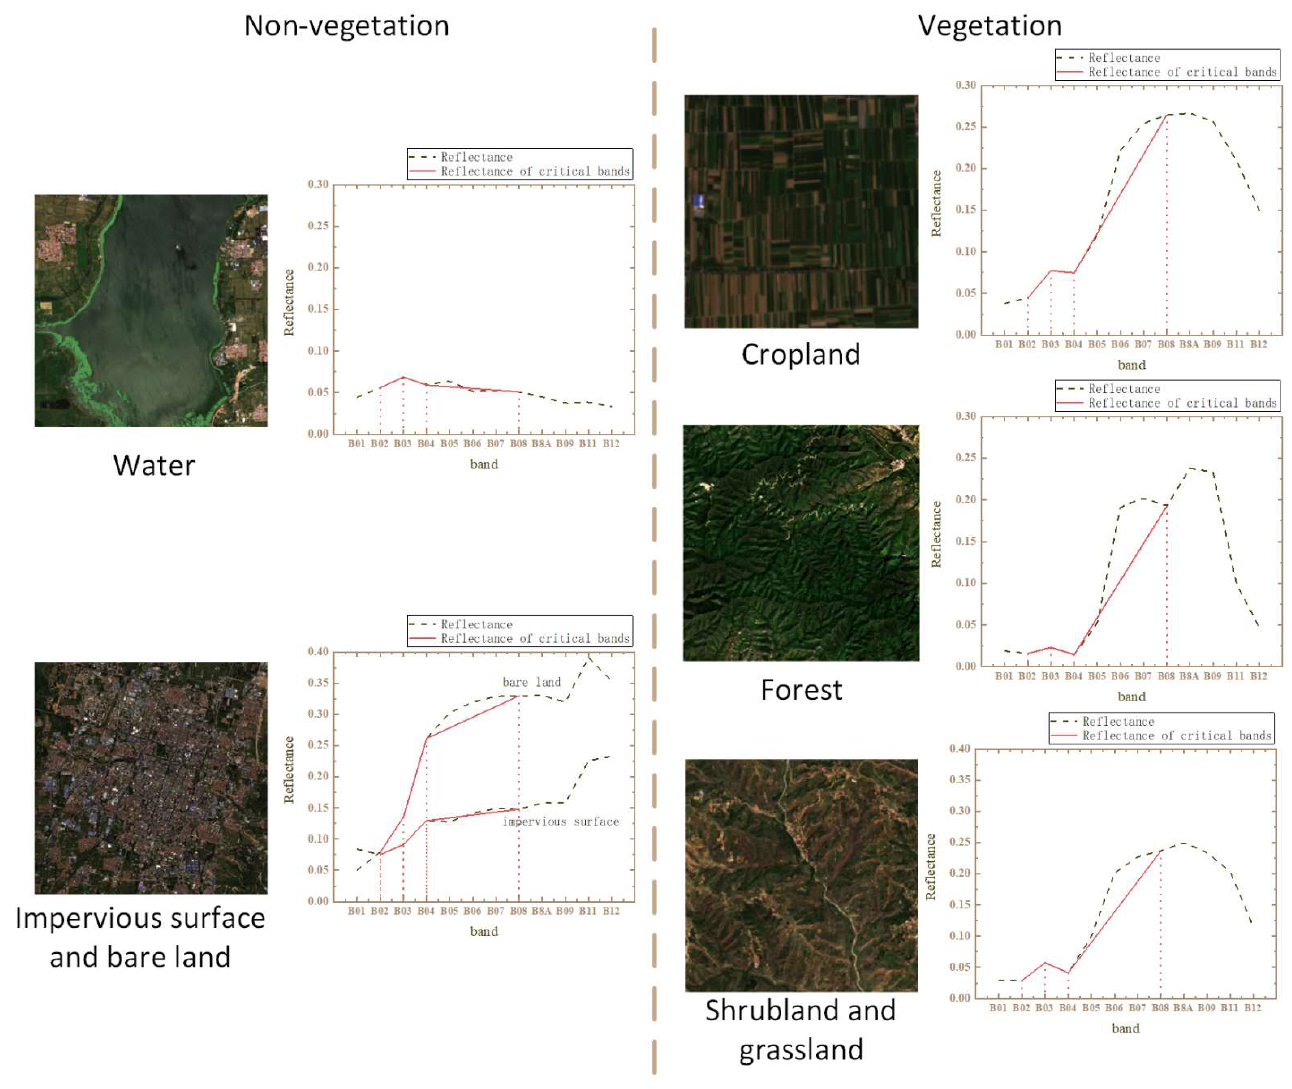
Figure 3. Satellite true-color images of each land use and their corresponding Sentinel-2 spectral curves. The black dotted line indicates the reflectance of all bands of sentinel-2 images. The solid red line represents the reflectance of each land use in red, green, blue, and near-red bands. These four bands are the key bands used in this paper.